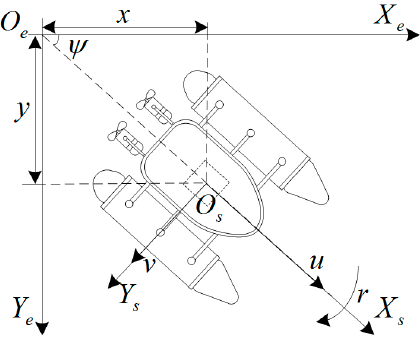
Figure 3. Schematic diagram of three DOF of the USV.